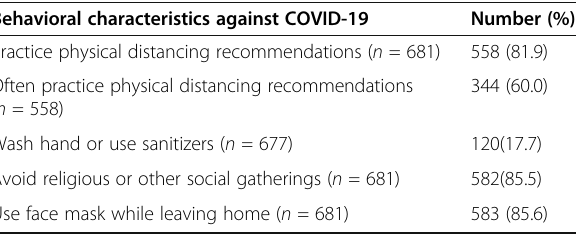
Table 2 Selected clinical and behavioral characteristics of study participants for SARS-CoV-2 seroprevalence, Dire Dawa,